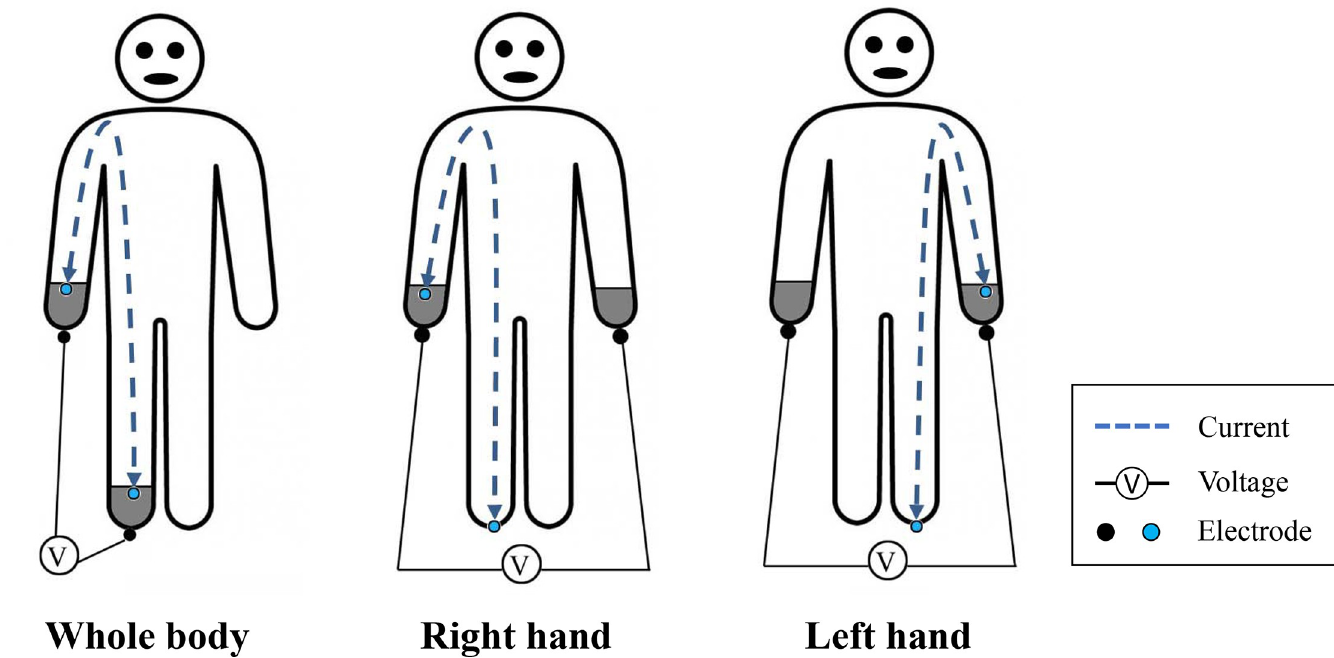
Fig 1. Illustration of impedance measurement methods for the respective body